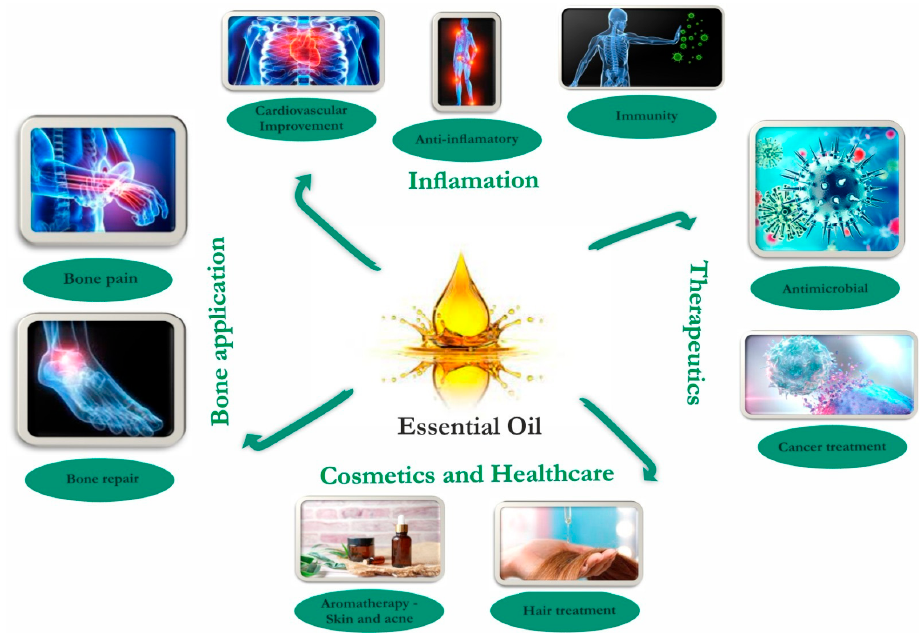
Figure 1. Domains of application of essential oils.